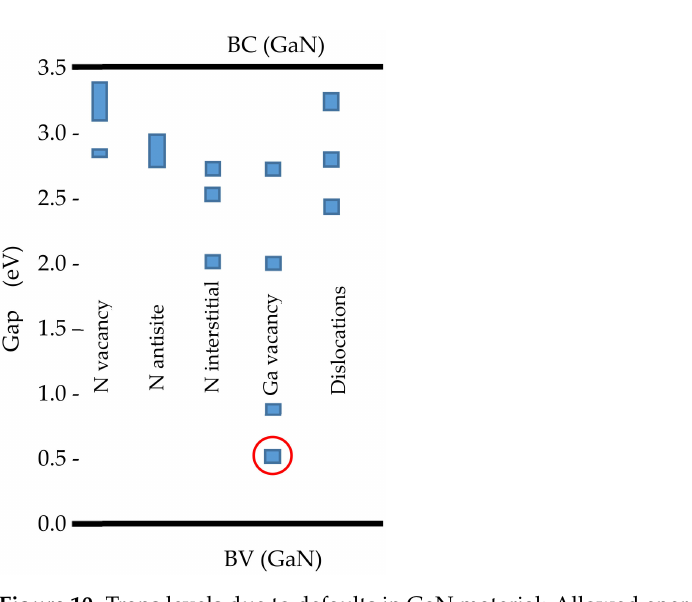
Figure 10. Traps levels due to defaults in GaN material: Allowed energy levels inside the forbidden GaN gap caused by intrinsic defects, dislocations. Zero energy correspond to the upper border of the valence band (own elaboration based on